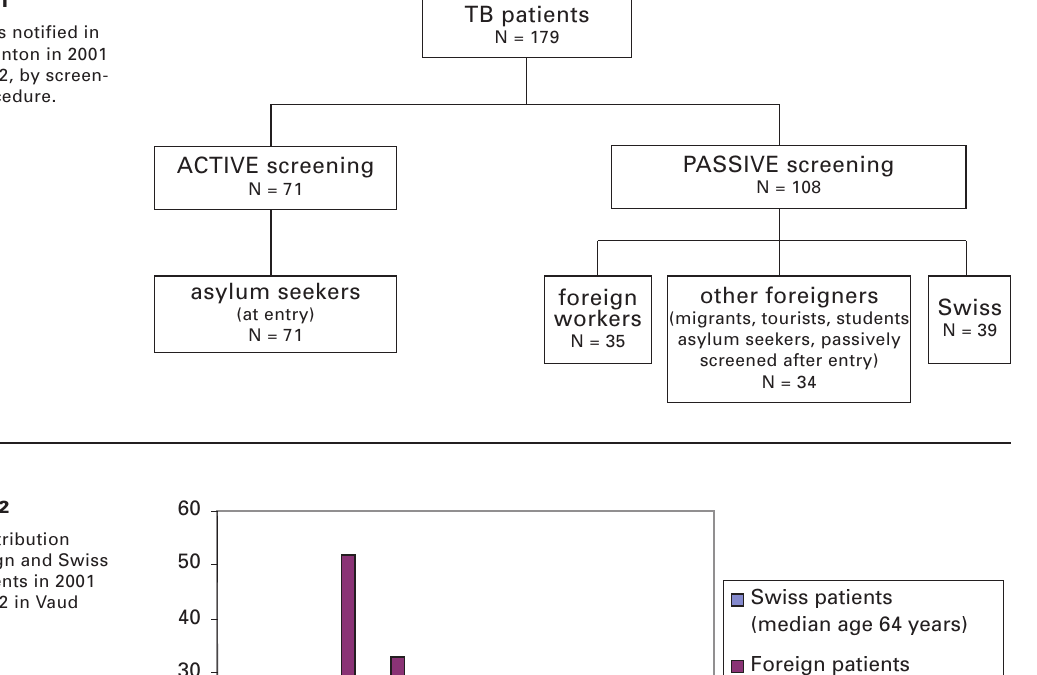
Age distribution of foreign and Swiss TB patients in 2001 and 2002 in Vaud (CH).